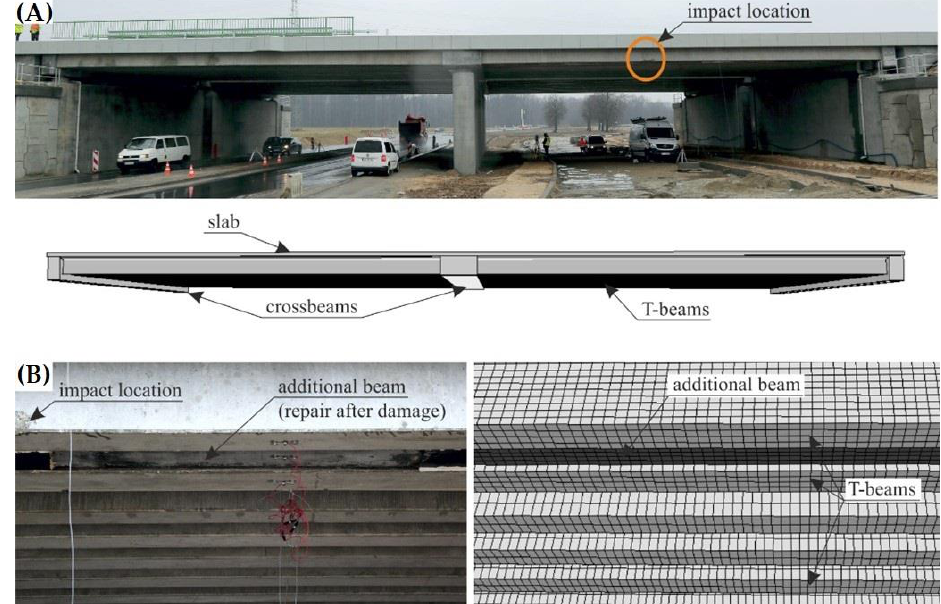
Figure 6. Comparison of the numerical model and the actual structure: ( A ) general view (the view of the FEM mesh view is turned off for better visibility), ( B ) view of the extreme T-beams and the additional beam made as a repair after the vehicle impact (the FEM mesh is visible).